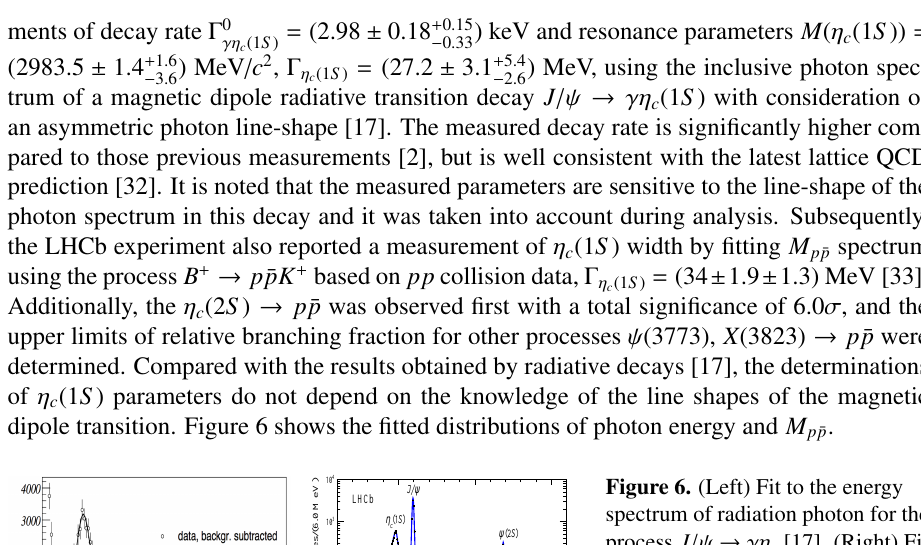
Figure 6. (Left) Fit to the energy spectrum of radiation photon for the process J /ψ → γη c [17]. (Right) Fit to the invariant mass of p ¯ p in the process B + → p ¯ pK + [33]. Dots with error bar are for the data. The solid line denotes the fit